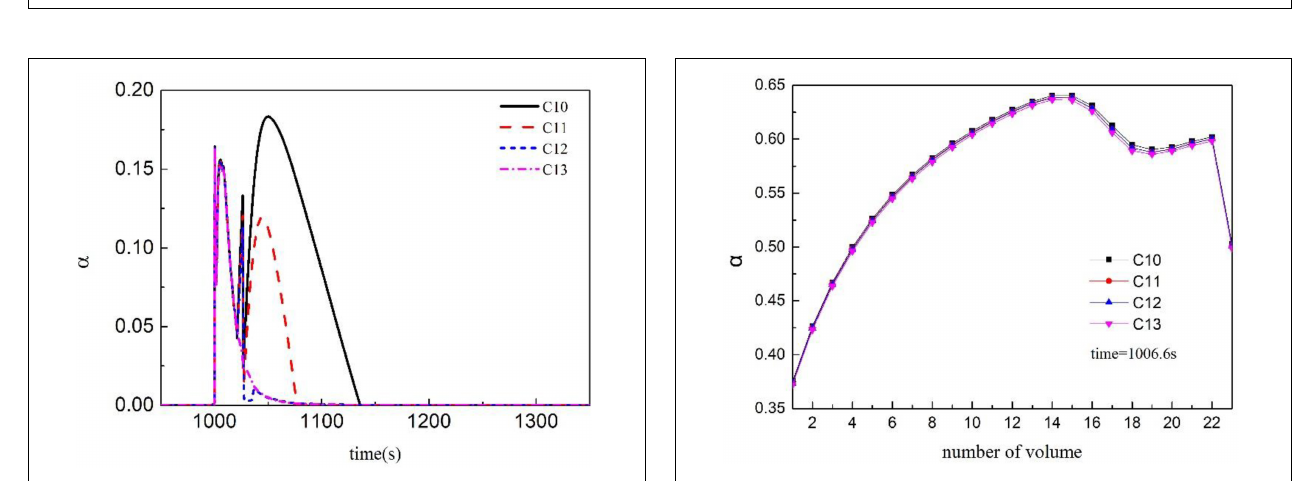
FIGURE 14 | Void fraction in low reference cup. FIGURE 15 | Void fraction of different volume of low reference